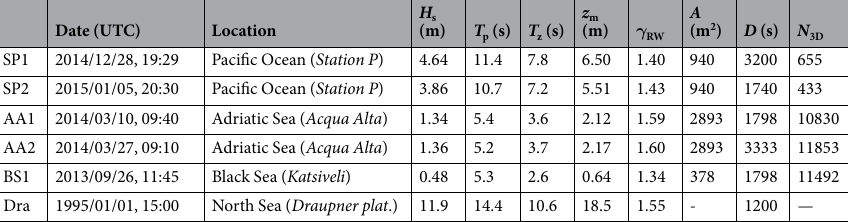
Table 1. Date and location of the wave observations (labeled as SP1, SP2, AA1, AA2, BS1) with the stereo systems. Wave parameters: H s is the significant wave height, T p the spectral peak period, T z the average zero- crossing period, z m the maximum sea surface elevation within the ST region spanning the sea surface area A and the duration D . N 3D is the theoretical number of individual 3D waves 34–36 over the ST region of volume AD . The rogue wave strength is given by the ratio γ RW = z m / H s . For the Draupner case (labeled as Dra), z m = max{ z ( t ) | t ∈ D }, in so far as only a time series z ( t ) was recorded at the platform.